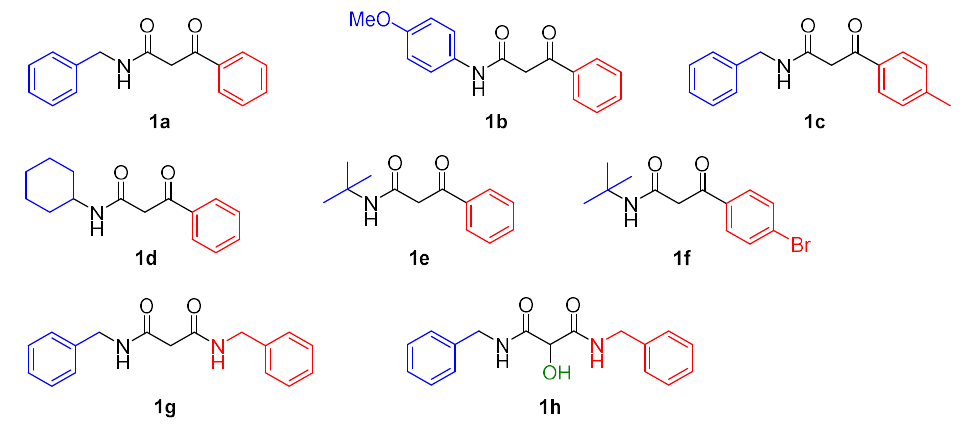
Figure 2. Dicarbonylic compounds tested as gelators.